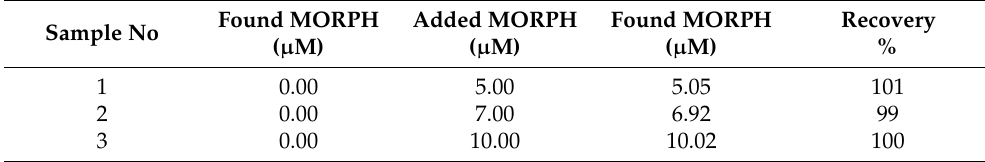
Table 2. Results for MORPH detection in urine